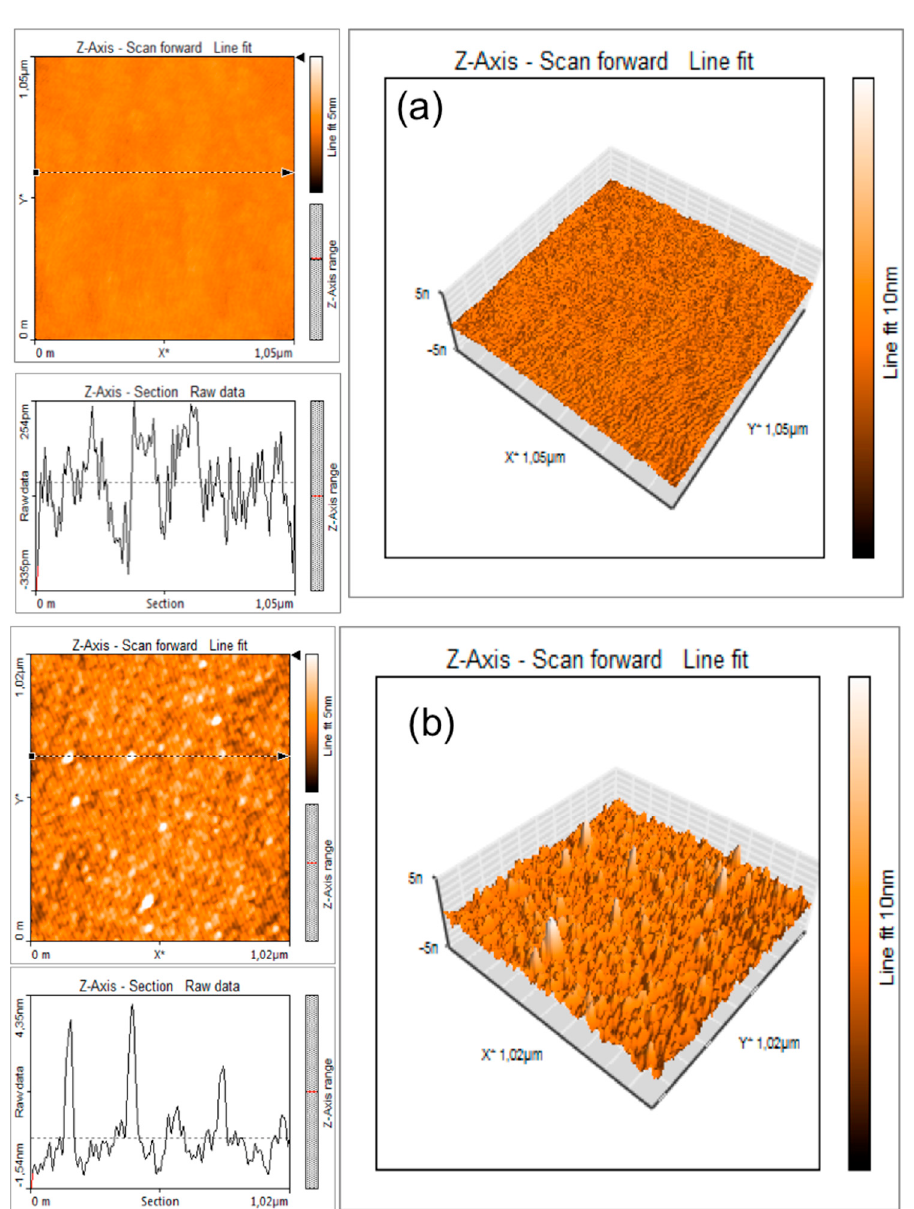
Figure 4. Roughness of the SrTiO 3 -modified electrode surface before ( a ) and after ( b ) antibody immobilization.